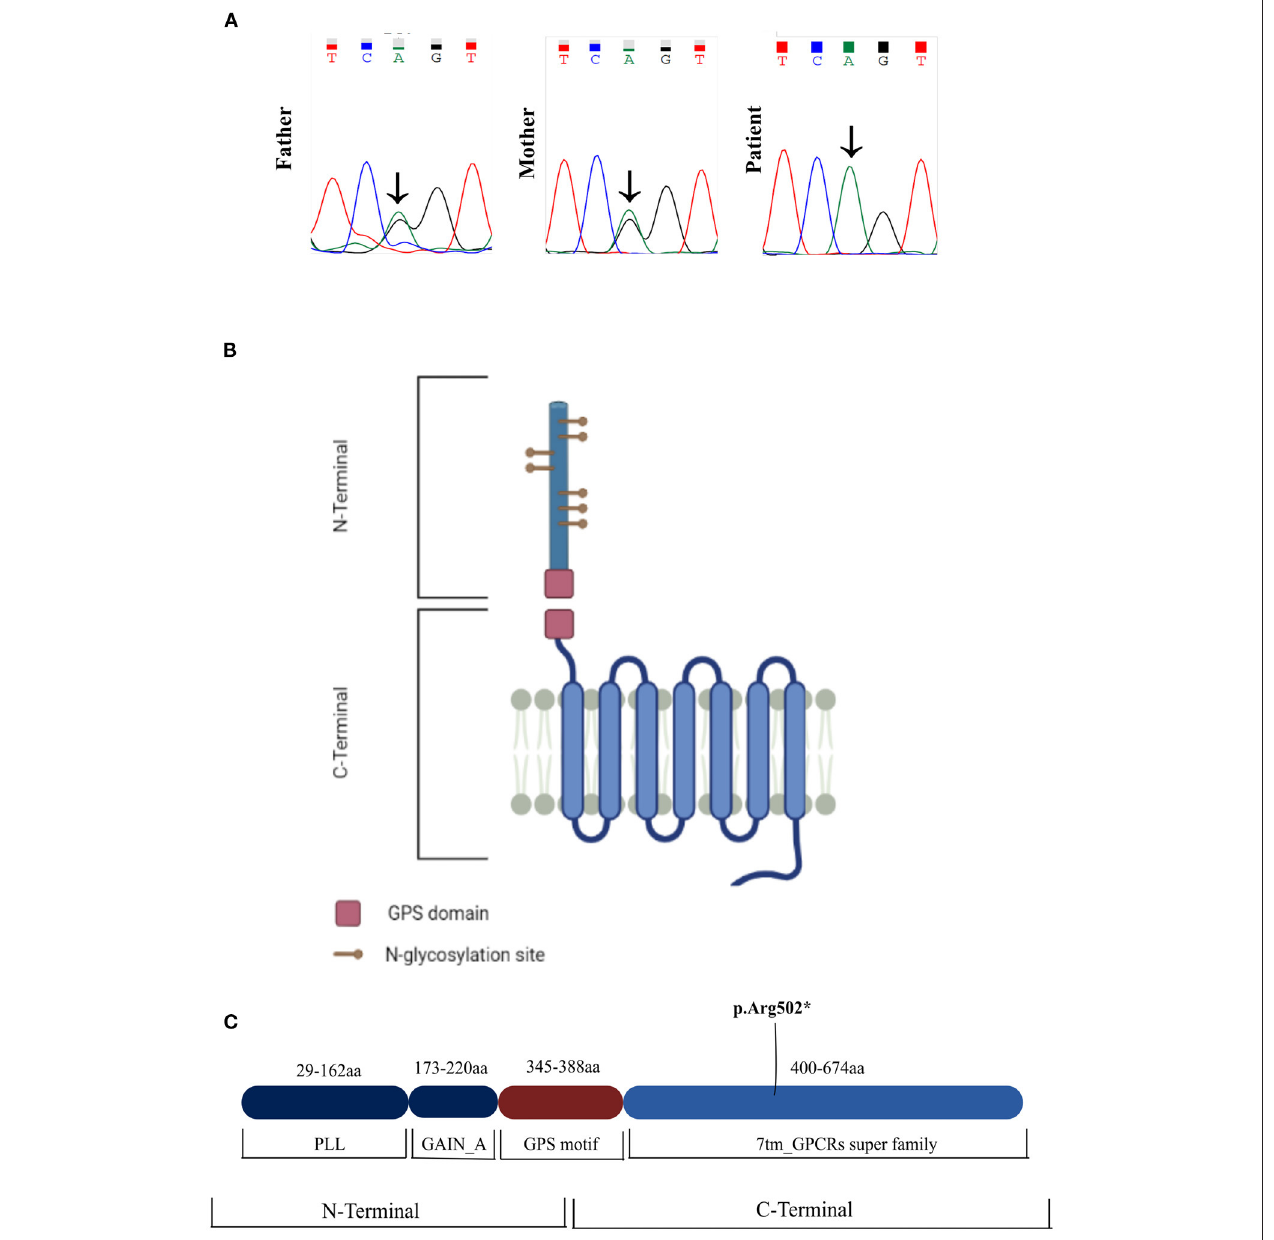
FIGURE 3 | (A) Sanger sequencing chromatograms of the patient and parents. The patient is a homozygous carrier of the nonsense variant c.1504C > T. The variant was present in the heterozygous state in both parents. (B,C) Schematic of the ADGRG1 protein, showcasing the novel variant in the 7TM domain of the protein (p.Arg502*). 7TM, 7 transmembrane domain; GAIN, GPCR-Autoproteolysis-INducing domain; GPS, GPCR proteolysis site motif; PLL, Pentraxin/Laminin/neurexin/sex-hormone-binding-globulin-Like